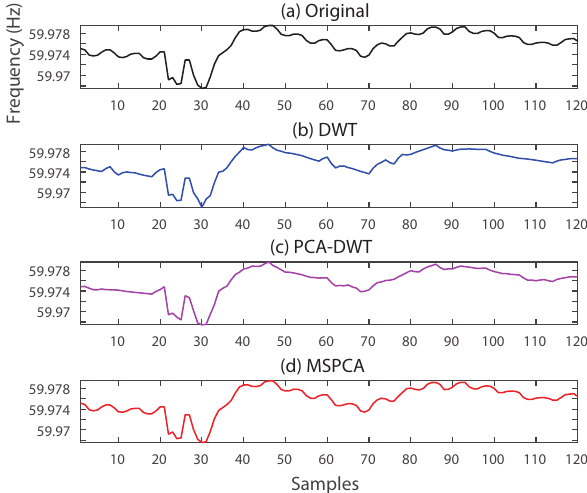
Figure 10. Comparison of reconstructed frequency signals. ( a ) Original data, ( b ) discrete wavelet transform (DWT), ( c ) PCA (principal component analysis)–DWT, ( d ) MSPCA (multiscale principal component